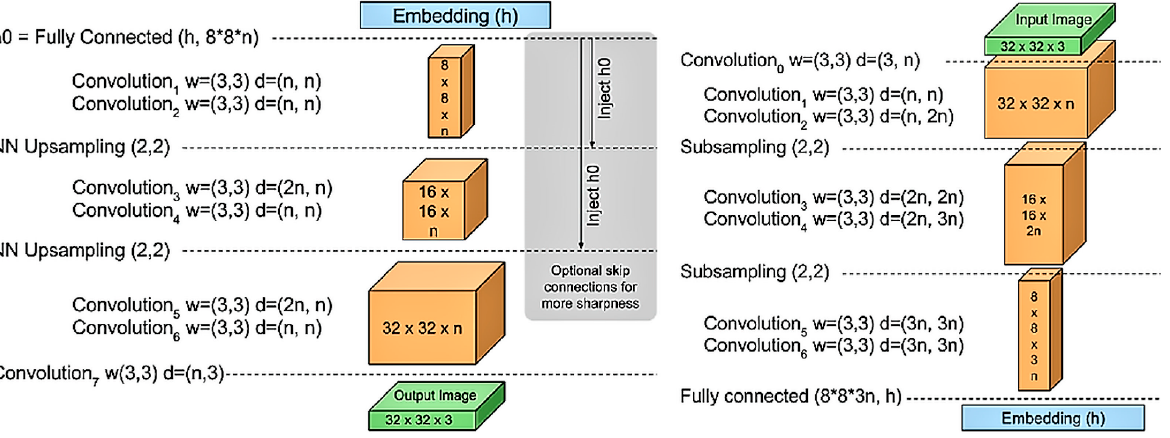
Figure 14. The architecture of the generator/decoder ( Left ), and the encoder ( Right ) for the given network.